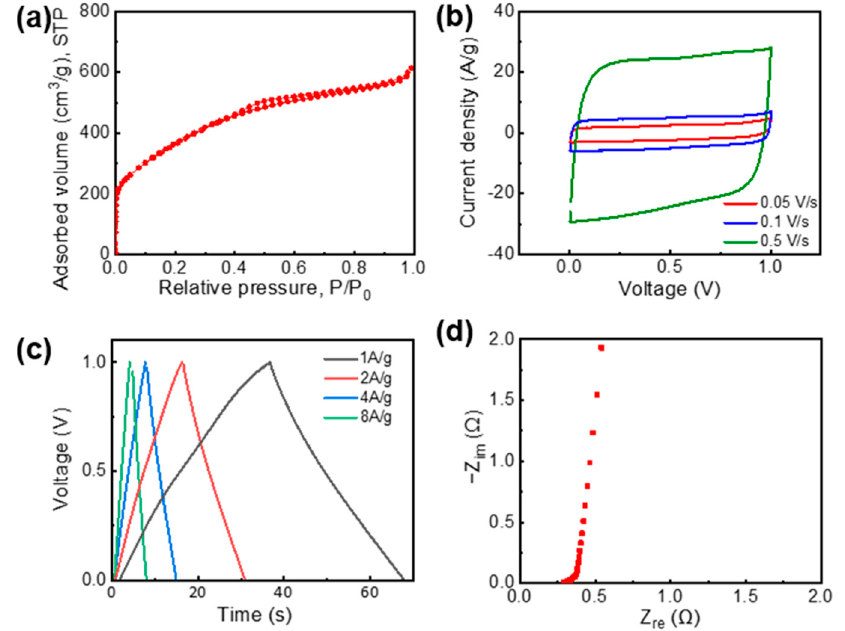
Figure 4. Pore characteristics and electrochemical performance of AG. ( a ) Nitrogen adsorption– desorption isotherms. ( b ) Cyclic voltammetry (CV) curves at scan rates of 0.05, 0.1, and 0.5 V/s. ( c ) Galvanostatic charge/discharge (GCD) curves at current densities from 1 to 8 A/g. ( d ) Nyquist plot.